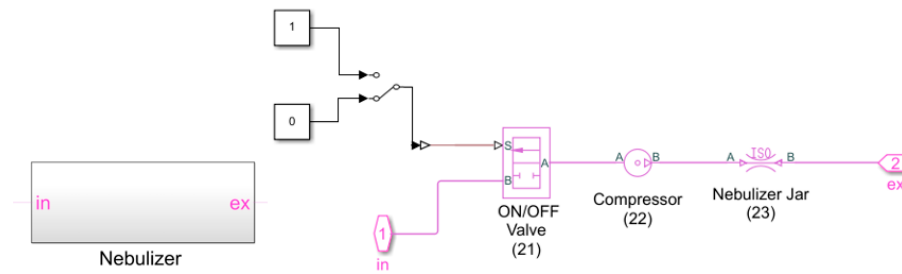
Figure 15. Subroutine reproducing the nebulizer.